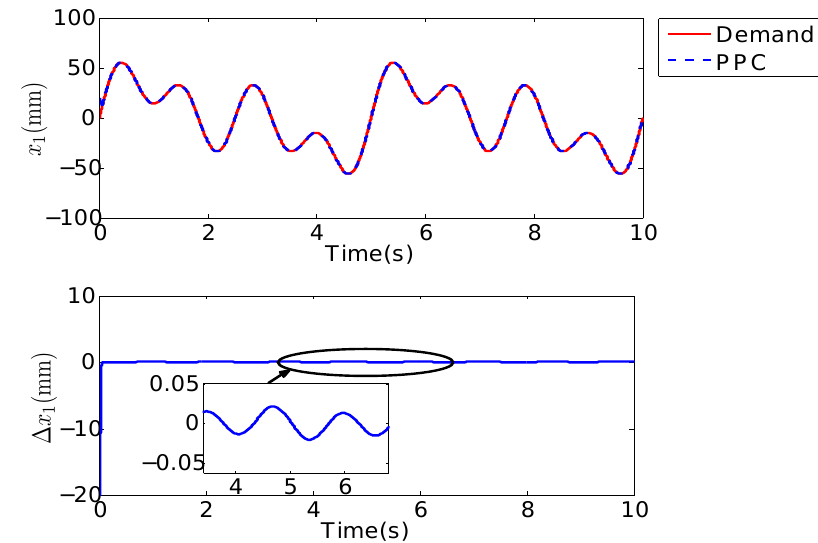
Figure 6. The cylinder position responses x 1 by prescribed performance constraint controller with ∆ ∆ 2 = 3 = 0, the demand y d = 25 ( sin ( 1.6 π t ) + sin ( 0.8 π t ) + sin ( 0.4 π t )) .